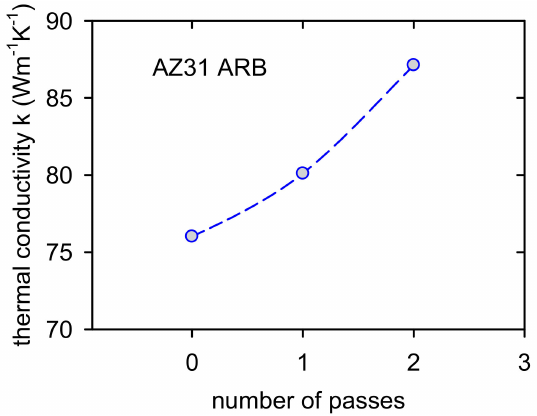
Figure 6. Thermal conductivity estimated at room temperature depending on number of